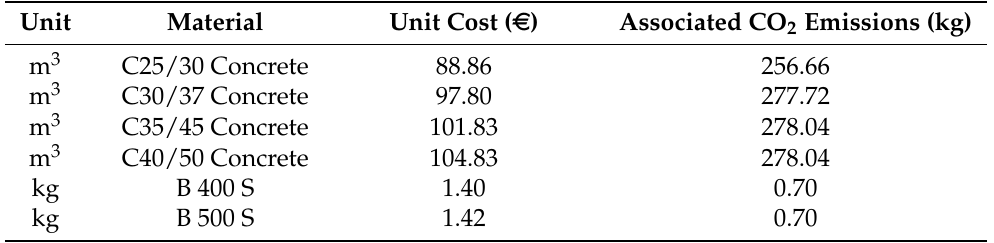
Table 1. Unit cost and associated CO 2 emissions values